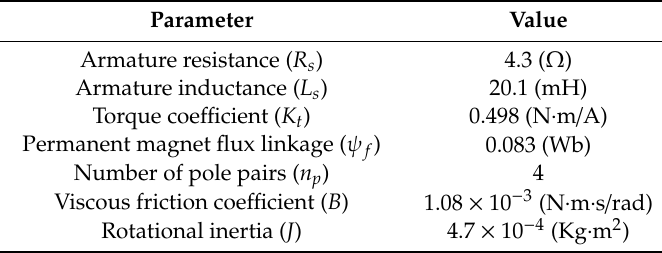
Table 1. Parameters of the PMSM.